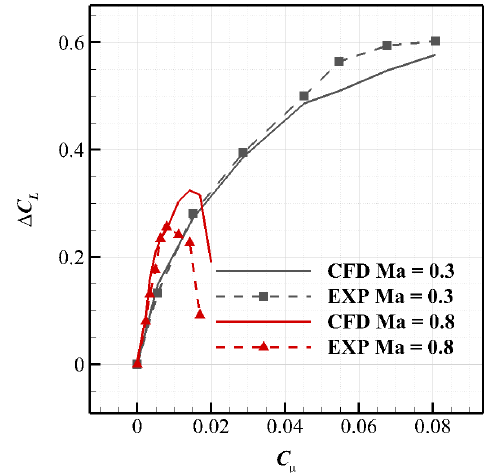
− C L C µ = 0 ) due to variation in C µ (cid:54) = 0